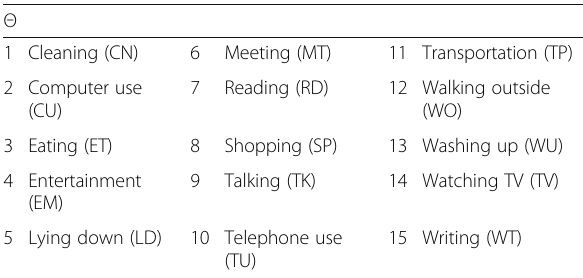
Table 5 The description of the discernment framework defined in Eq.